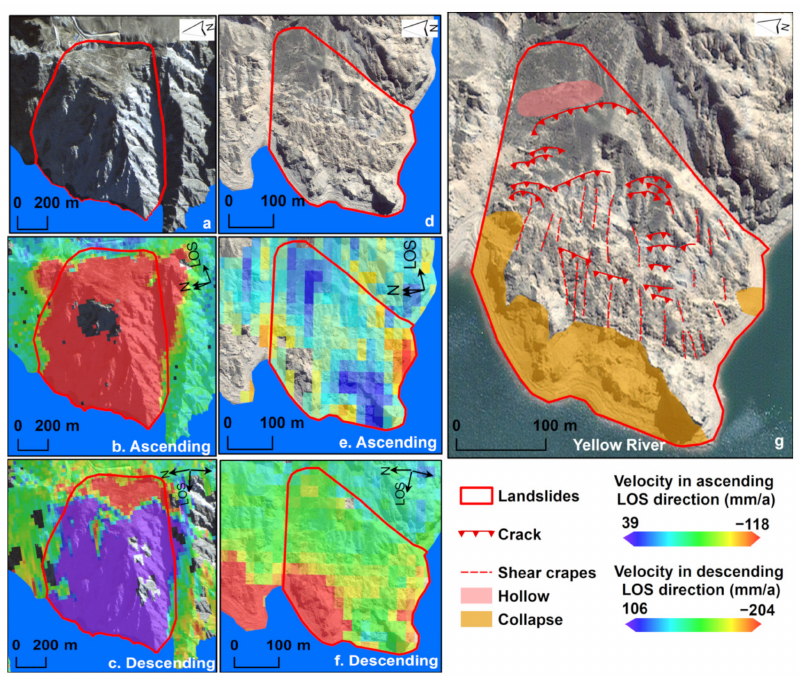
Figure 3. Interpretation characteristics of active landslides from ascending and descending Sentinel- 1 radar data. ( a ) optical image of Guobu landslide; ( b , c ) InSAR deformation in ascending and descending LOS direction of Guobu landslide; ( d ) optical image of Longyang landslide; ( e , f ) InSAR deformation in ascending and descending LOS direction of Longyang landslide; ( g ) interpretation features of Longyang